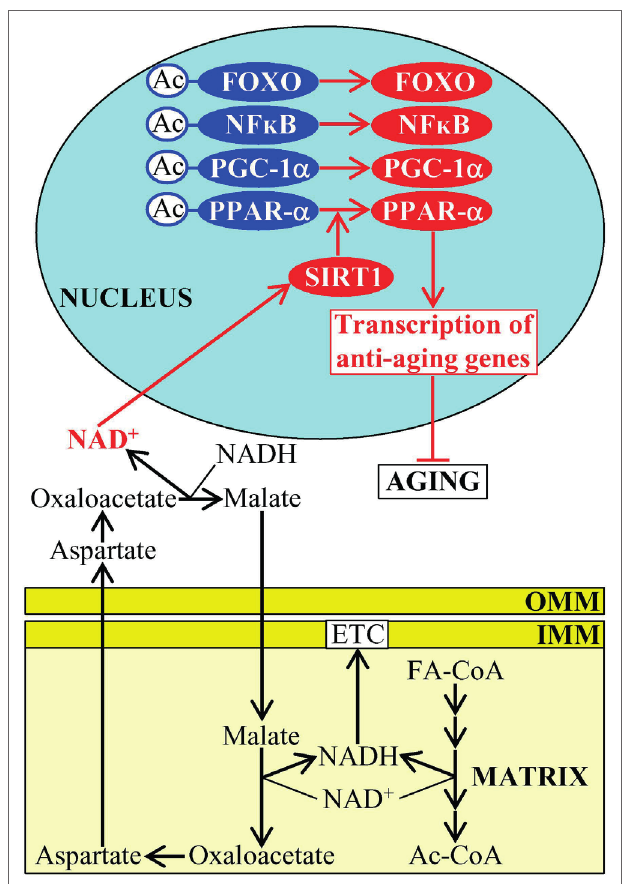
FIGURE 1 | Mitochondrial metabolism influences NAD + concentrations in other cellular locations, thus contributing to the aging process. An activation of fatty acid oxidation and a malate-aspartate shuttle in mitochondria elicits an increase in the concentration of cytosolic NAD + , which then stimulates the NAD + - dependent type III deacetylase SIRT1 in the nucleus. Once stimulated, SIRT1 deacetylates and activates several transcription factors that promote expression of many nuclear genes encoding aging-delaying proteins. Activation arrows and inhibition bars denote pro-aging (displayed in blue color) or anti-aging processes (displayed in red color). Pro-aging or anti-aging proteins are displayed in blue or red color, respectively. See the text for additional details. Abbreviations: Ac, acetyl group; Ac-CoA, acetyl CoA; FA-CoA, fatty acyl-CoA ester; ETC, electron transport chain; FOXO, forkhead transcription factor; IMM, inner mitochondrial membrane; NF κ B, nuclear factor kappa B; OMM, outer mitochondrial membrane; PGC-1 α , peroxisome proliferator-activated receptor gamma coactivator 1-alpha; PPAR- α , peroxisome proliferator-activated receptor alpha; SIRT1, sirtuin (silent mating type information regulation 2 homolog) type